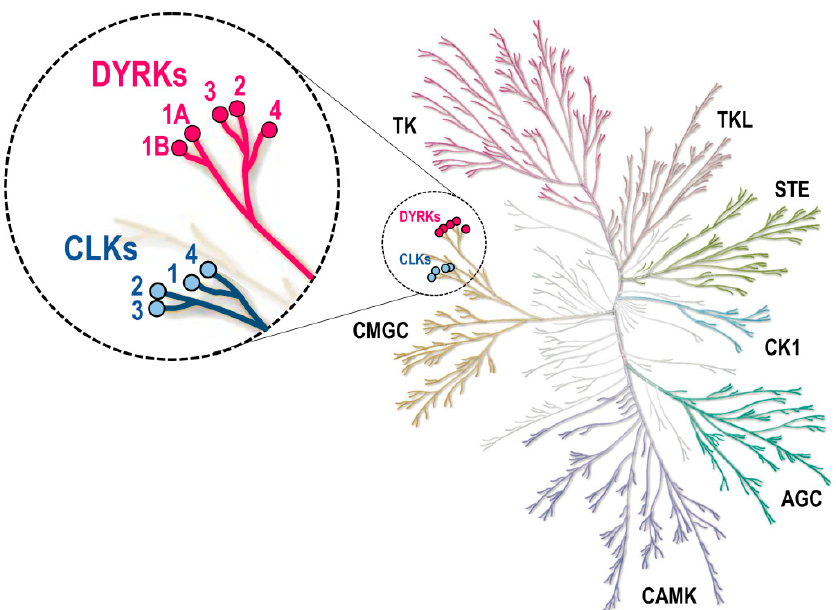
Figure 2. DYRKs and CLKs within the human kinome phylogenetic tree. DYRK and CLK family